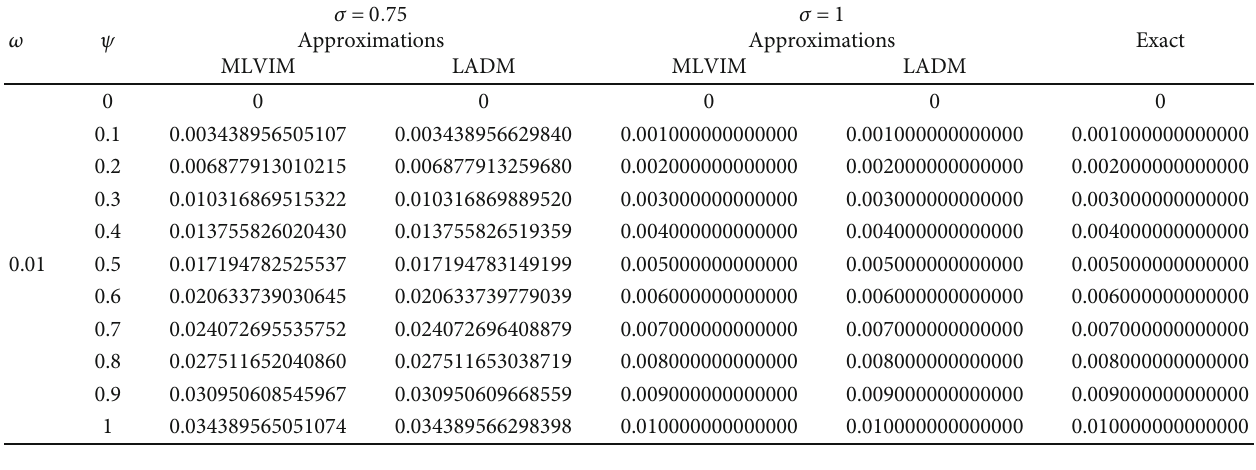
Table 1: Comparison of LADM and MLVIM solution for the fi rst three approximations with exact solution for ω = 0 : 2 , with mesh points ψ = 0 : 1 , for equation (22).